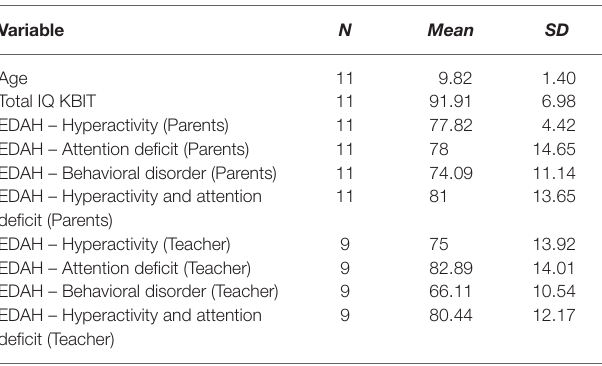
TABLE 1 | Mean symptom severity characteristics of attention deficit hyperactivity disorder (ADHD)